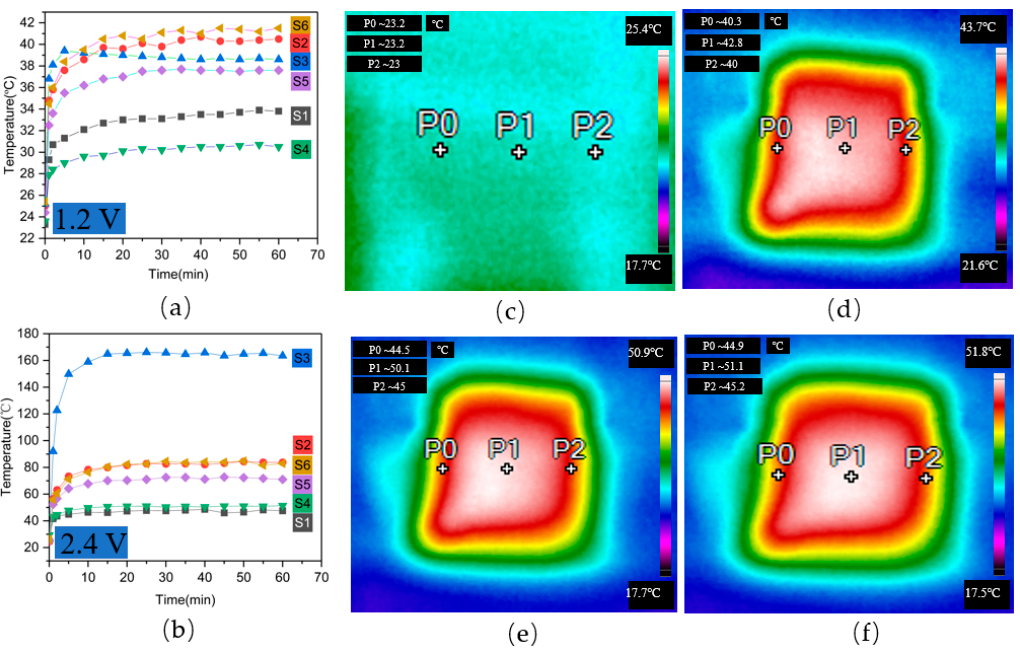
Figure 7. Sample temperature change with time of S1–S6 under ( a ) 1.2 V and ( b ) 2.4 V and thermal images of S4 ( c ) before and ( d ) after 1 min, ( e ) after 30 min, and ( f ) after 1 h of application of a voltage of 2.4 V.